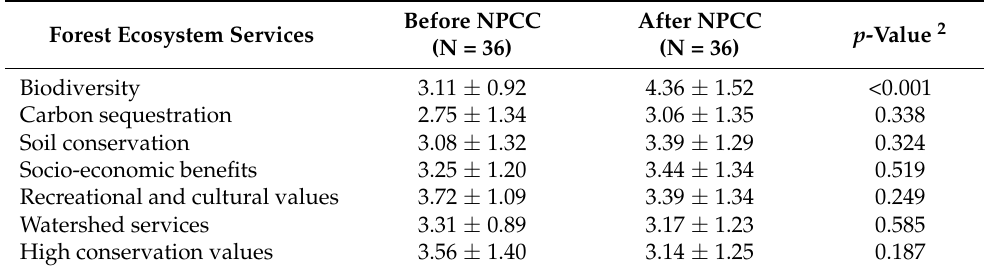
Table 1. Effectiveness scores of the implemented adaptation actions by forest ecosystem services before and after NPCC 1 .